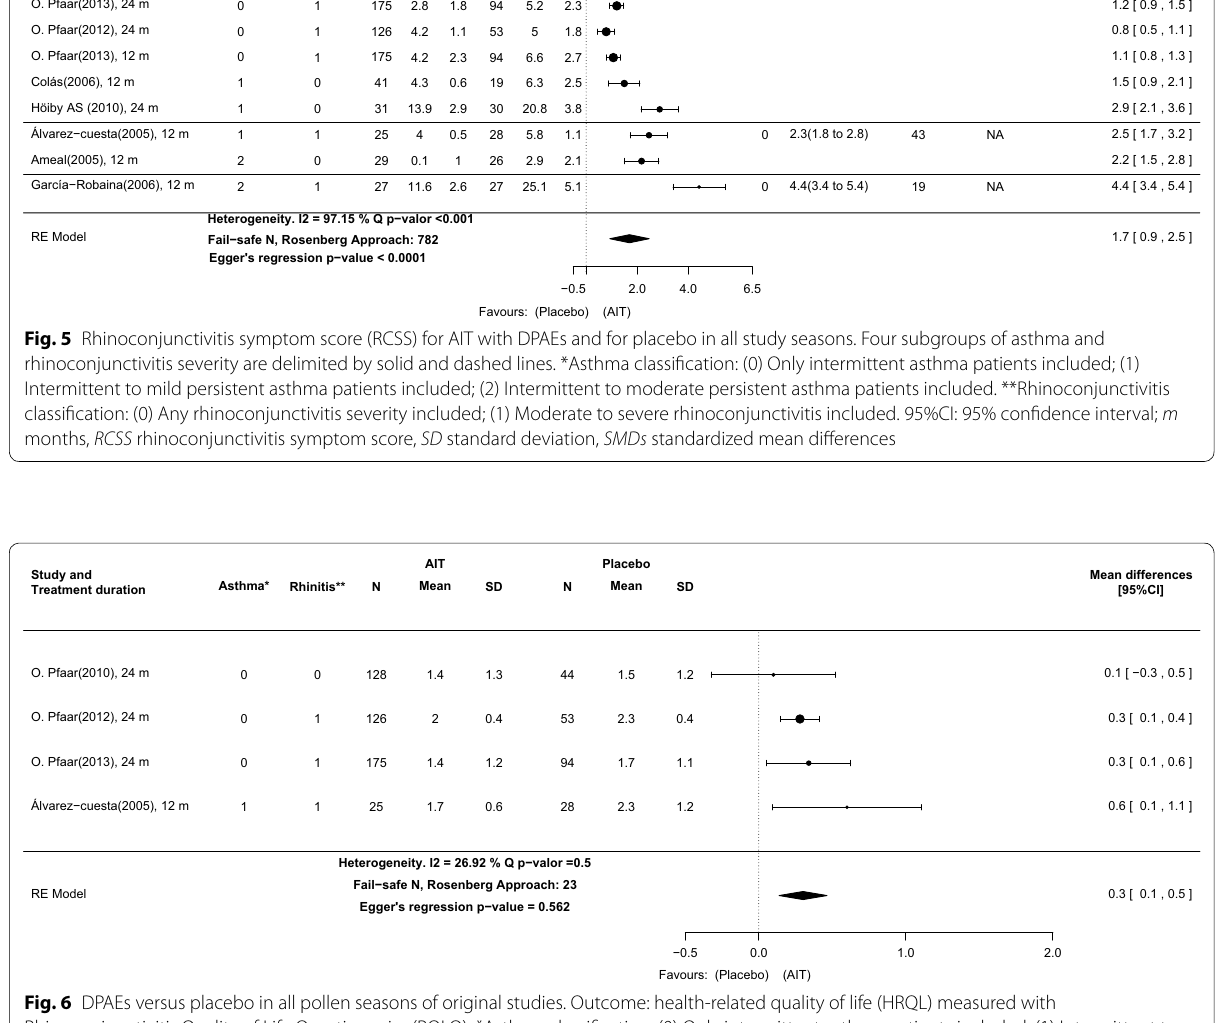
severity scores were: 0.4, (95% CI: 0.1–0.7), 1.1 (95% CI: 0.9–1.2), 2.6 (95% CI: 2.1–3.1) and 5.1 (95% CI: 3.9–6.2) for scores 0, 1, 2 and 3, respectively. Additionally, no sig- nificant (p > 0.1) or relevant (I 2 < 25%) degree of hetero- geneity were observed between the studies belonging to these subgroups (Table 4).